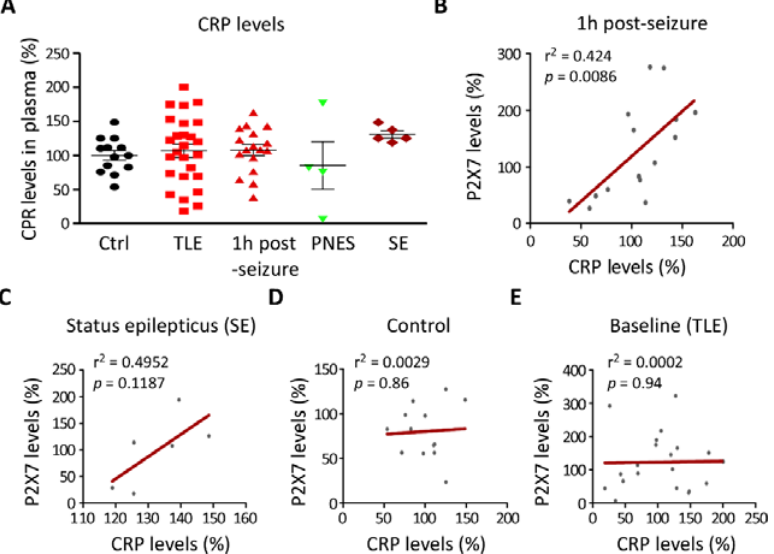
Figure 2. Correlation between P2X7R plasma levels with CRP plasma levels. ( A ) Bar chart showing C-Reactive protein (CRP) plasma levels in healthy controls (Ctrl) (N = 13), TLE patients (N = 26), 1 h post-seizure (N = 17), patients with PNES (N = 4), and patients suffering from status epilepticus (SE) (N = 5). Data are given as percentage to control. ( B – E ) Correlation between CRP plasma levels and P2X7R plasma levels 1 h post-seizure (N = 15; r 2 = 0.42, p = 0.0086), during status epilepticus (N = 6; r 2 = 0.49, p = 0.11), in healthy controls (N = 13, r 2 = 0.0029, p = 0.86), and in TLE patients at baseline (N = 19; r 2 = 0.0002, p = 0.94).